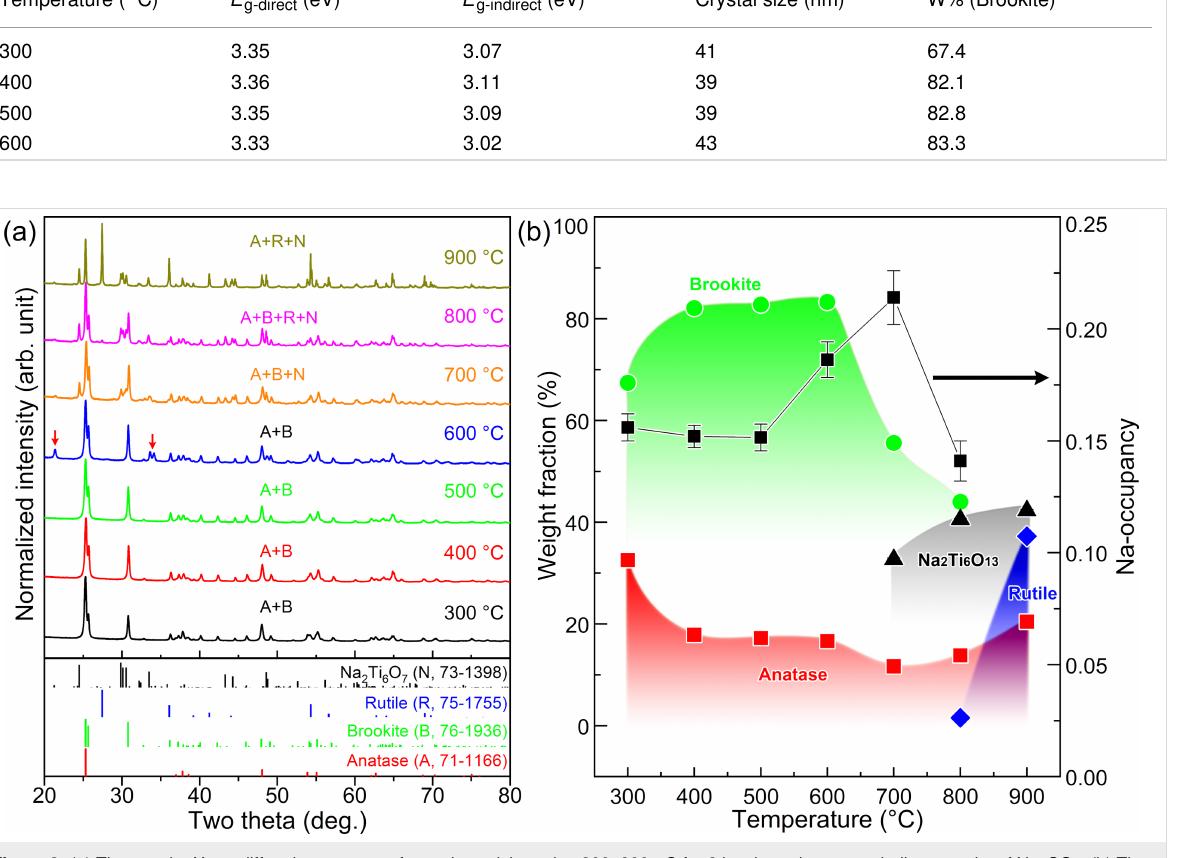
brookite (B) and anatase (A) with typical features: peaks at